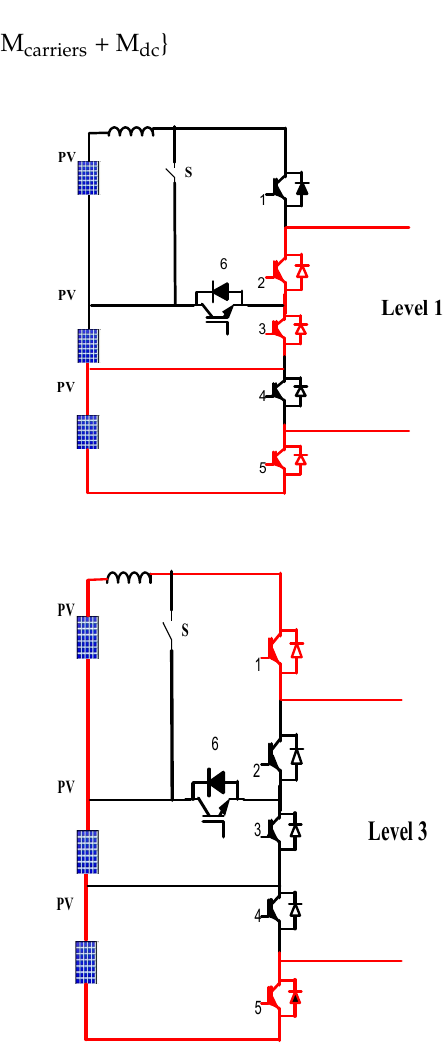
Figure 6. Switching sequence of RVT MLI.